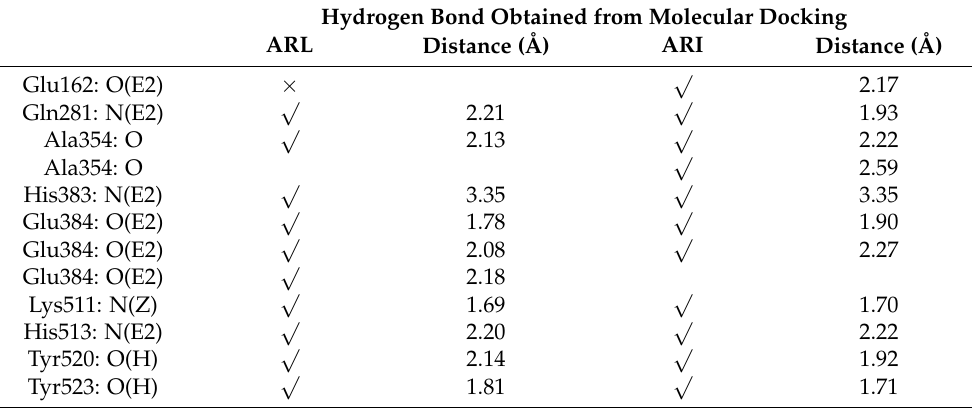
Table 4. Hydrogen bonds observed between best bioactive peptide poses obtained from docking results and ACE.